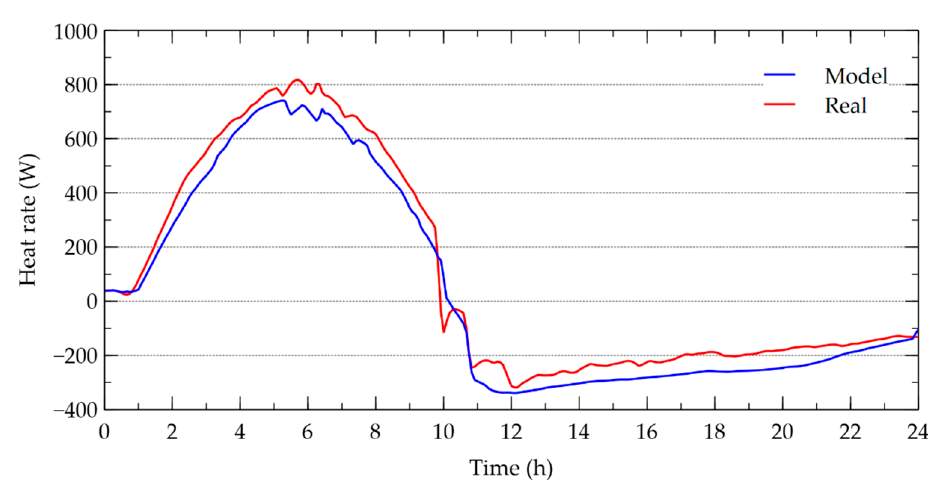
Figure 7. Estimated absorbed heat rate.